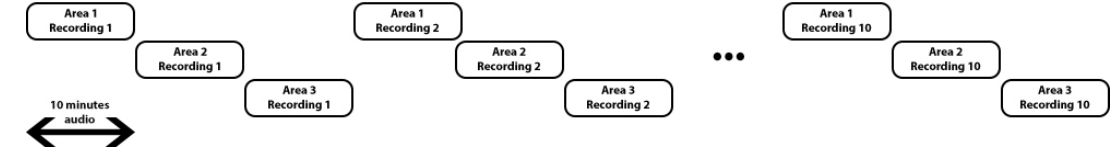
Figure 3. A diagram explaining how the recording was